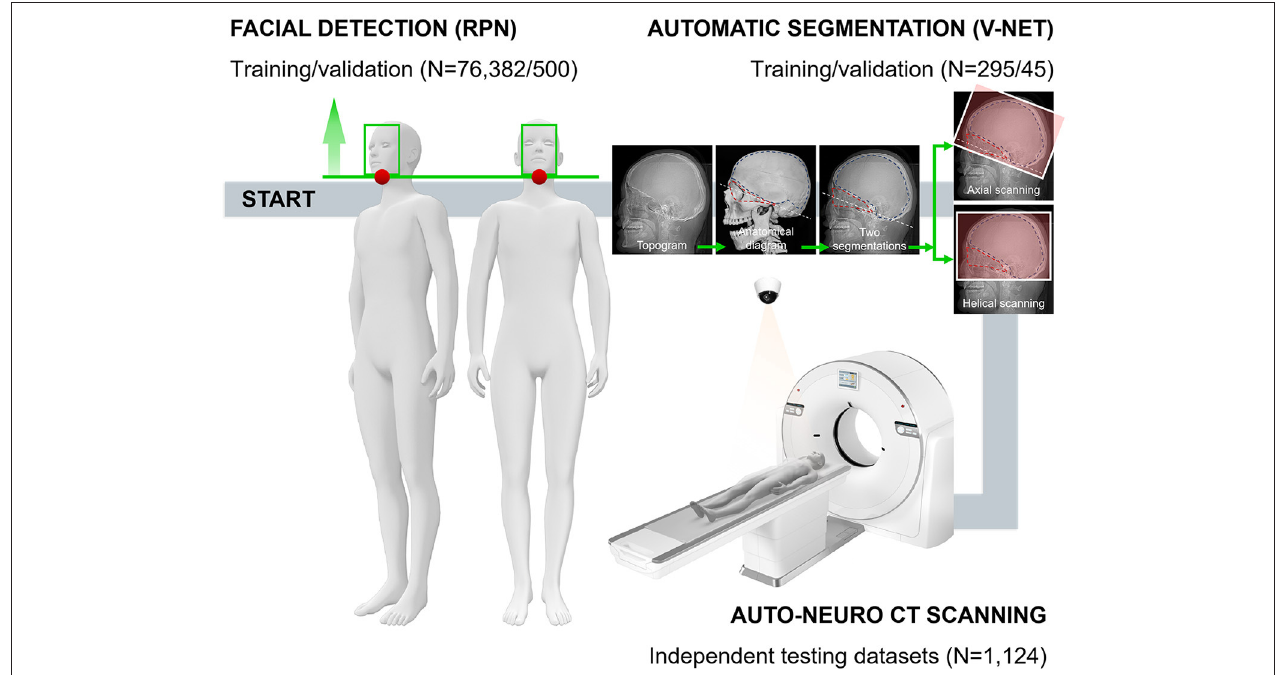
FIGURE 1 | The technical framework of CAPITAL-CT implementation and the entire workflow with respective numbers for each dataset. Following the daily operation logic and habits of imaging to perform the overall process of enriching traditional CT with AI. In the automatic segmentation part, a human skull with dotted lines facilitates readers’ understanding of how we chose the segmentation area and the